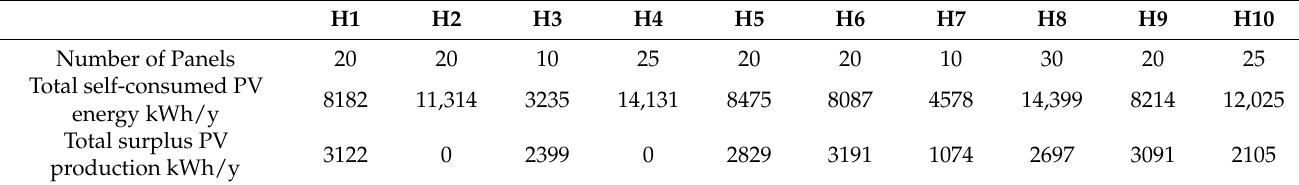
Table 4. Case 1 Houses H1:H10 number of panels and PV energy generation details.